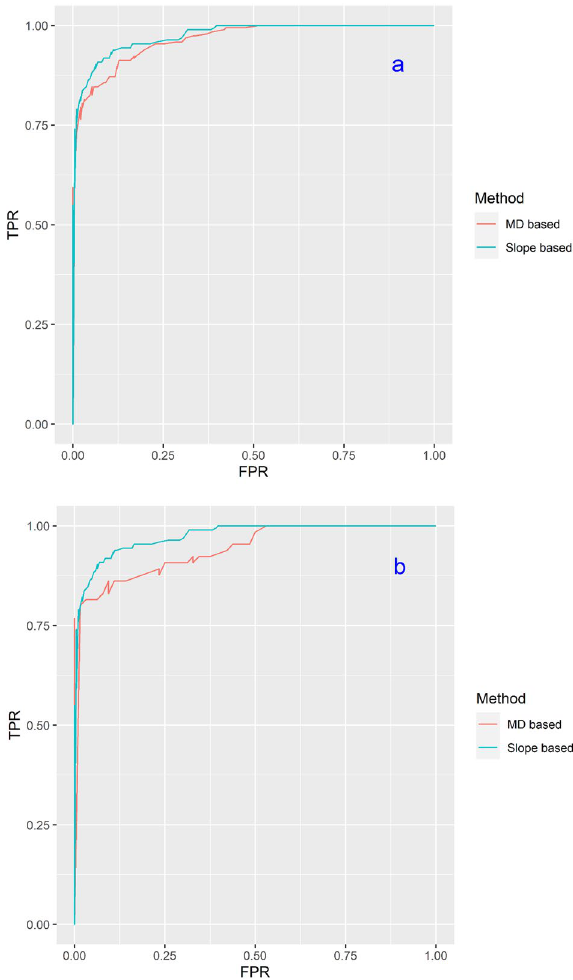
Figure 10. ROC curves for MD and slope based susceptibility maps: ( a ) training dataset (Slope based, AUC = 0.89; MD based AUC = 0.87); ( b ) validation dataset (Slope based AUC = 0.86; MD based AUC =